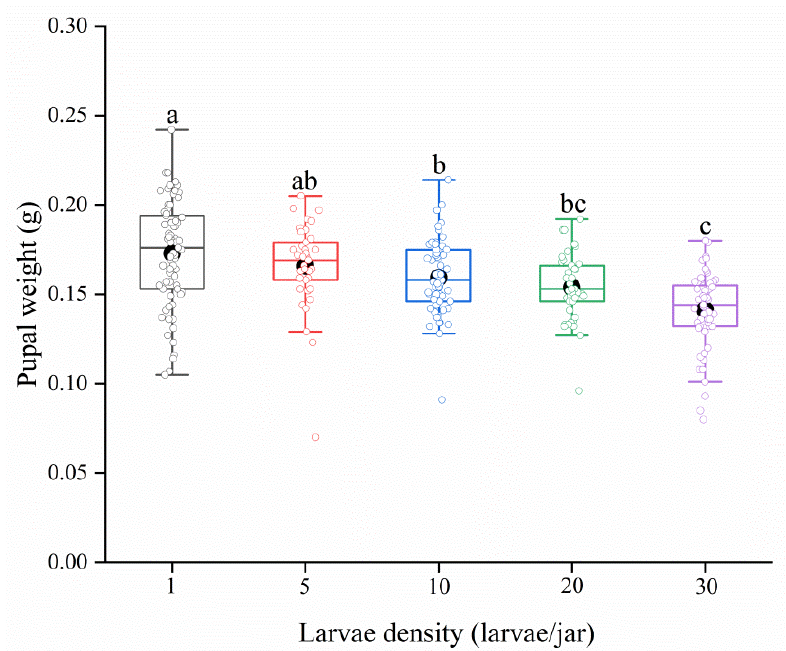
Figure 1. Pupal weight of Spodoptera frugiperda under different larval densities. Solid black bars represent the maximum line, median line and minimum line (from top to bottom in each boxplot). Boxplots display a mean dot, IQR boxes, 1.5*IQR whiskers and observed values (open circle). Different lowercase letters above group bars indicate significant differences among different larvae densities by Tukey’s HSD test at 5% level. The sample sizes from left to right are 71, 37, 65, 41 and 60, respectively.